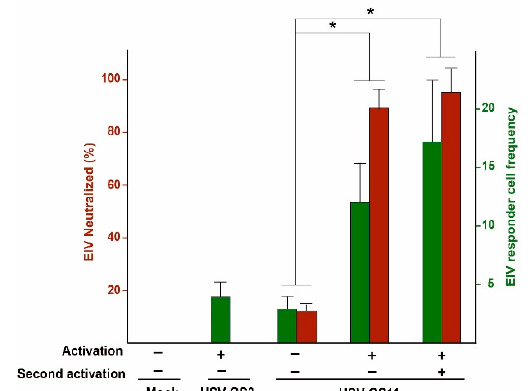
Figure 3. Immunization with activated HSV-GS11 induced a robust immune response against EIV Prague / 56 HA. For neutralizing antibody assessments: groups ( n = 5) of 6 to 8 week old female BALB / c mice were inoculated on both rear footpads with either saline (mock), HSV-GS3 (50,000 PFU), or HSV-GS11 (50,000 PFU). Vector replication was activated in some treatment groups by administration of heat and ulipristal. One treatment group received a second activation treatment that was administered 2 days after the first activation treatment. Twenty-one days post-immunization, mouse serum samples were tested for their ability to neutralize EIV Prague / 56. The values are presented as percentages of EIV Prague / 56 neutralized. For responder cell frequency assays, immunizations and treatments were as above. Twenty-one days post-immunization, the number of EIV Prague / 56 HA-specific lymphocytes was determined using a limiting dilution lymphocyte proliferation assay. The data are presented as the responder cell frequency of each experimental group; *, p ≤ 0.05). See Reference [40] for the original report of the results shown in this figure.